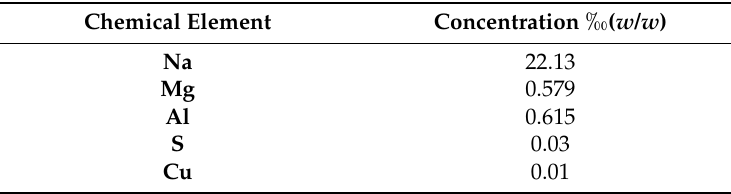
Table 1. X-ray fluorescence analysis of IVS320.